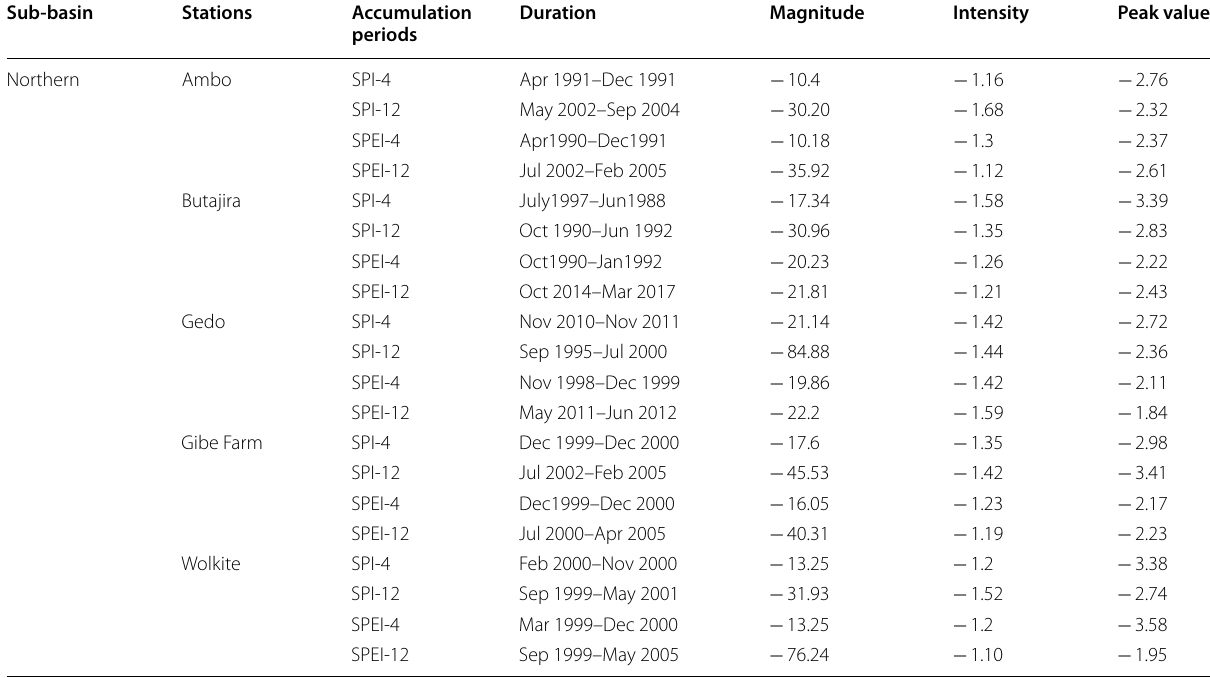
1) duration, magnitude, intensity, and peak value in the northern part of OGRB ≤ −